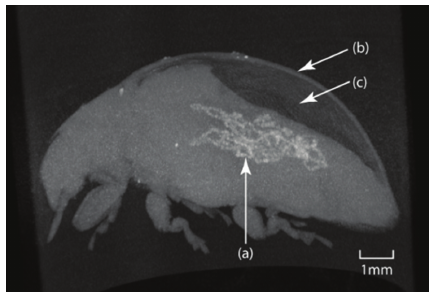
Figure 5: A 3D, volume rendered, micro-CT image of a male C. septempunctata using Maximum Intensity Projection (MIP) showing (a) radio opaque malpighian tubules, (b) elytra, and (c) folded wings in the air space between elytra and